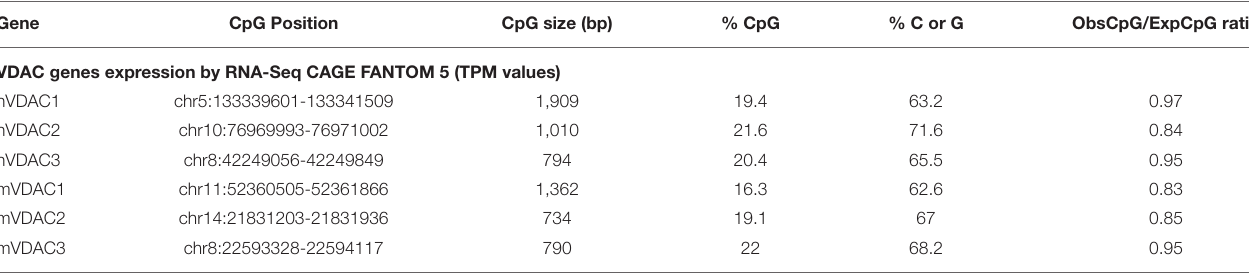
TABLE 2 | Overview of CpG islands (CGIs) content in human and mouse promoters of VDAC genes. Gene CpG Position CpG size (bp) % CpG % C or G ObsCpG/ExpCpG ratio VDAC genes expression by RNA-Seq CAGE FANTOM 5 (TPM